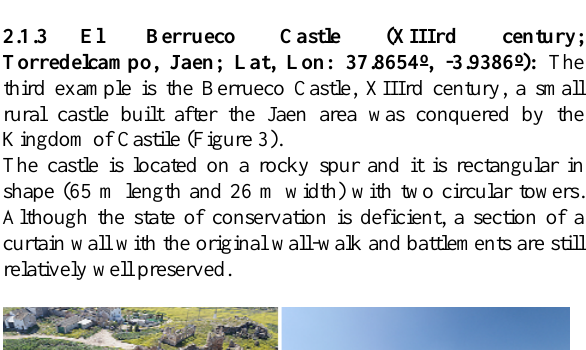
Figure 2. Burgalimar Castle (Xth century). Top: General view, the keep tower was built in XVth century; Lower left: horseshoe arch at the main entrance. Lower right: aerial view from the UAS.